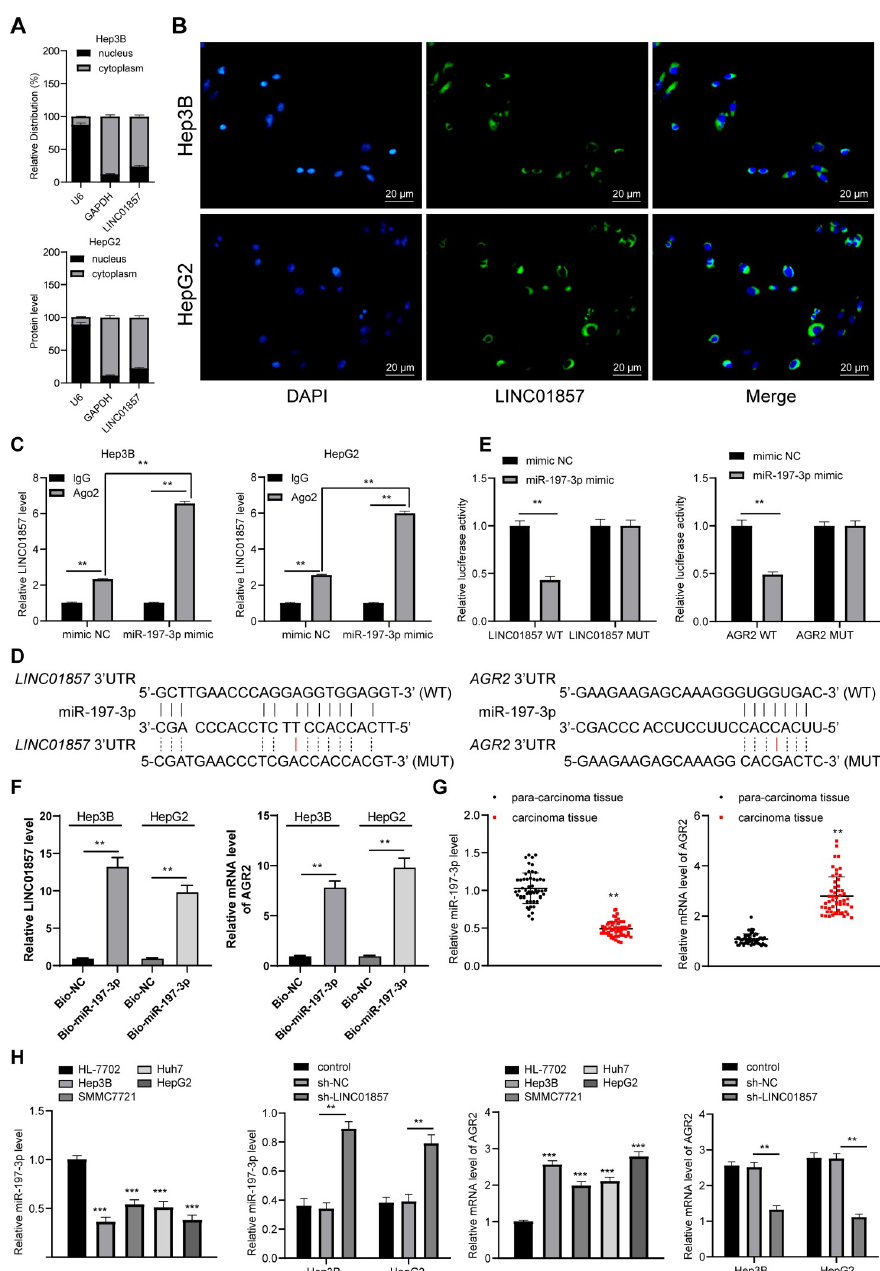
Fig 3. LINC01857 competitively binds to miR-197-3p to improve AGR2 expression. A, LINC01857 expression in HCC cells detected by fractionation of nuclear and cytoplasmic RNA and RT-qPCR. B, fluorescence localization of LINC01857 in HCC cells verified by RNA-FISH. C, binding relation between LINC01857 and miR-197-3p verified by RIP assay; D: binding sites between LINC01857 and miR-197-3p and between miR-197-3p and AGR2 predicted by RNA22 and TargetScan database. E-F, binding relations between LINC01857 and miR-197-3p and between miR-197- 3p and AGR2 certified by RIP assay and dual-luciferase reporter gene assay. G, expression of miR-197-3p and AGR2 mRNA in HCC and paracancerous tissues examined by RT-qPCR, n = 54. H, expression of miR-197-3p and AGR2 mRNA in HCC cells assessed by RT-qPCR. Three independent repeated cell tests were conducted. The results were presented as mean ± standard deviation. The paired t-test was employed to analyze the data in panels G/F. One-way ANOVA was used to analyze the data in panel H. Tukey’s multiple comparisons test was applied for post hoc test. Two-way ANOVA was employed to analyze the data in panels A, C, E, and H. Tukey’s multiple comparisons test or Sidak’s multiple comparisons test was employed for the post hoc test. �� p < 0.01, ��� p < 0.001.